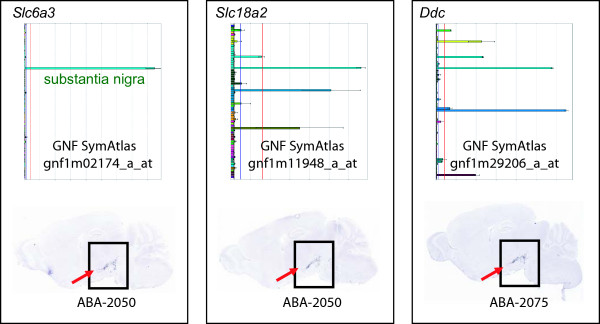
Gene expression of Slc6a3, Slc18a2, and Ddc. All three genes are enriched in the brain substantia nigra region as indicated by the arrow. Brain images were obtained from the ABA database and the tissue gene expression data were obtained from GNF SymAtlas.